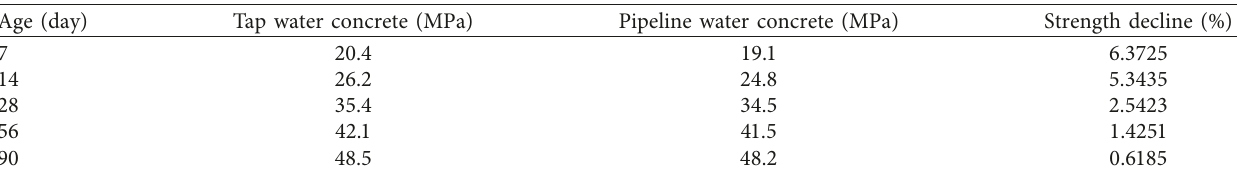
Table 7: The results of the compressive strength test of concrete made by using tap water and pipeline water with 50% of granite aggregate. Age (day)